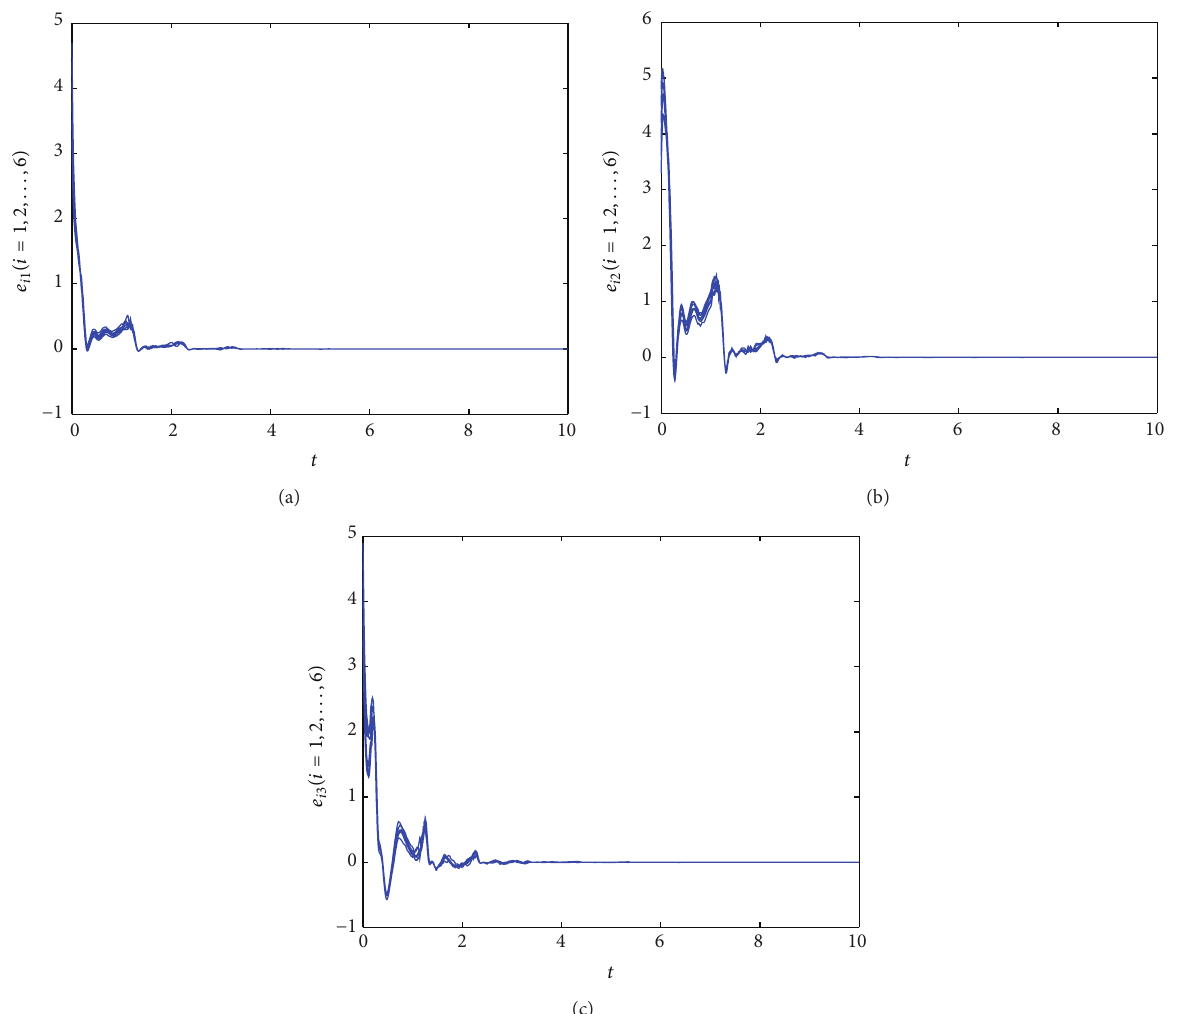
Figure 2: Errors of the drive-response coupled networks: (a) 𝑒 𝑖1 ; (b) 𝑒 𝑖2 ; (c) 𝑒 𝑖3 .